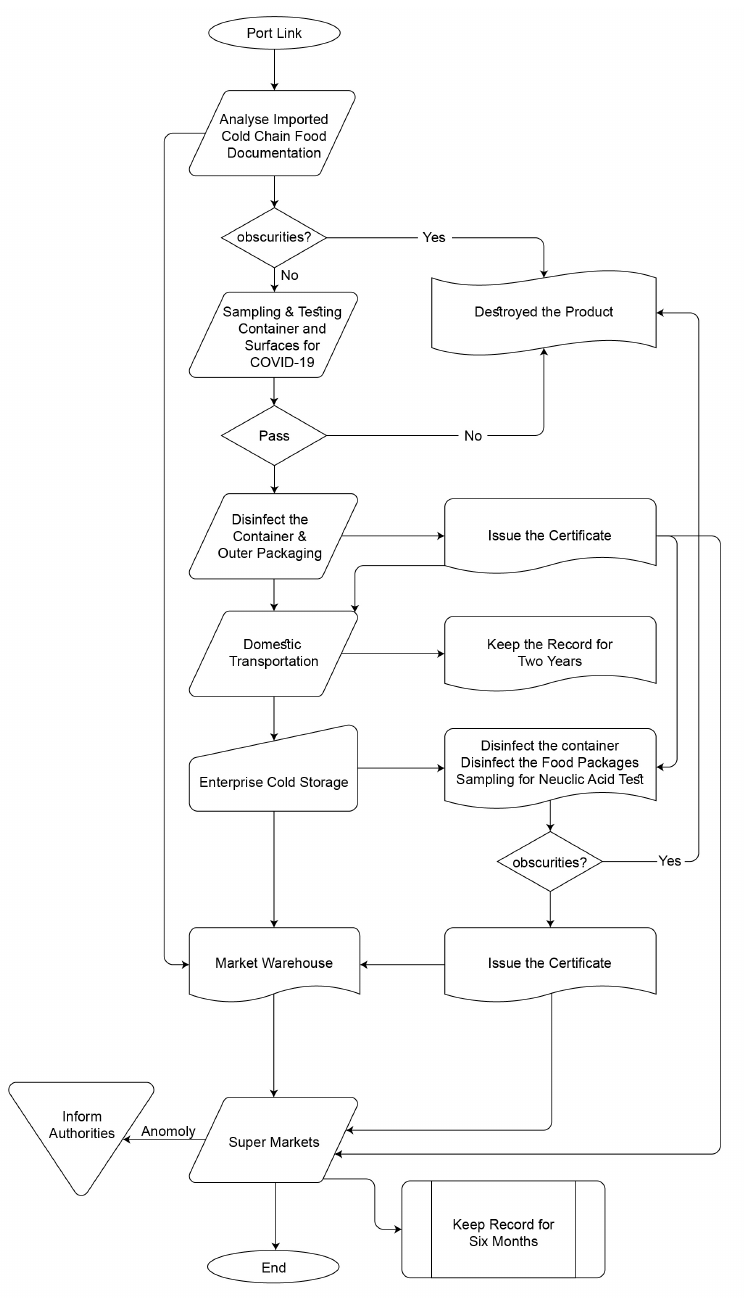
Figure 4. The import process of cold chain products